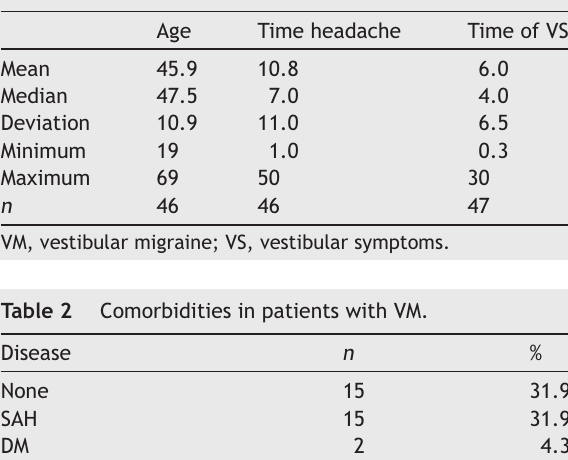
Age and duration of symptoms (years) in patients with VM.